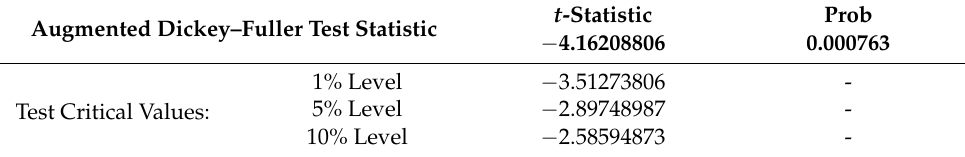
Table 1. ADF test results of offset azimuth.